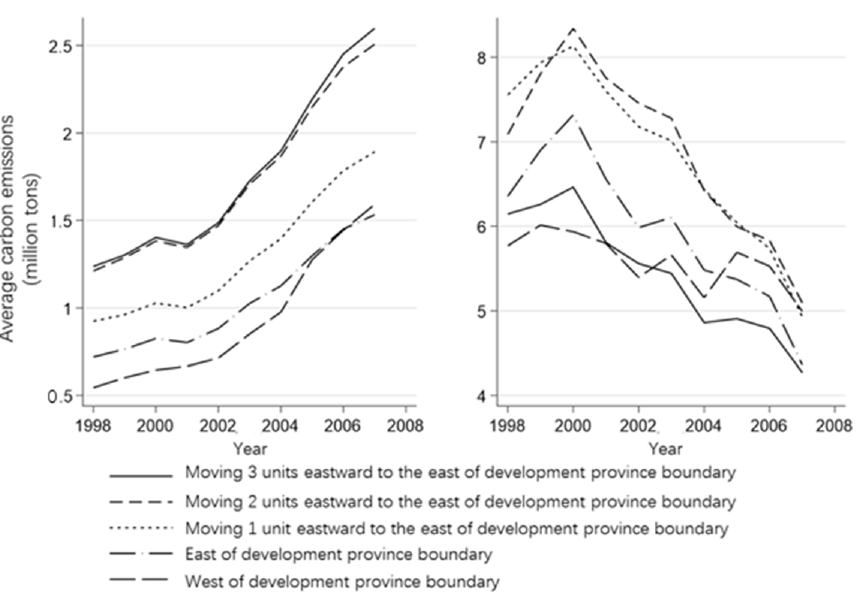
Figure 2. Average carbon emission intensity and average carbon emission of five types of counties on both sides of the development province boundary in each year.